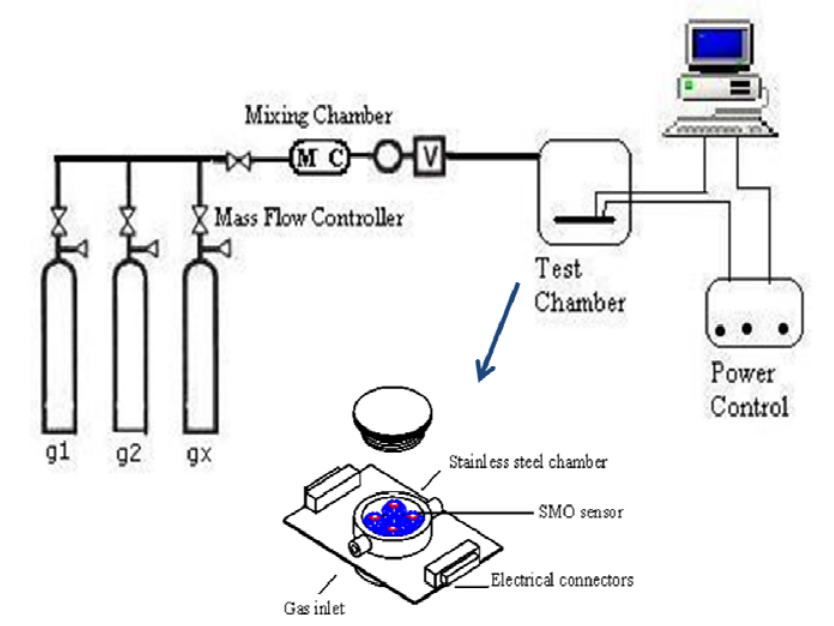
Figure 1. A general schematic for SMO gas sensor